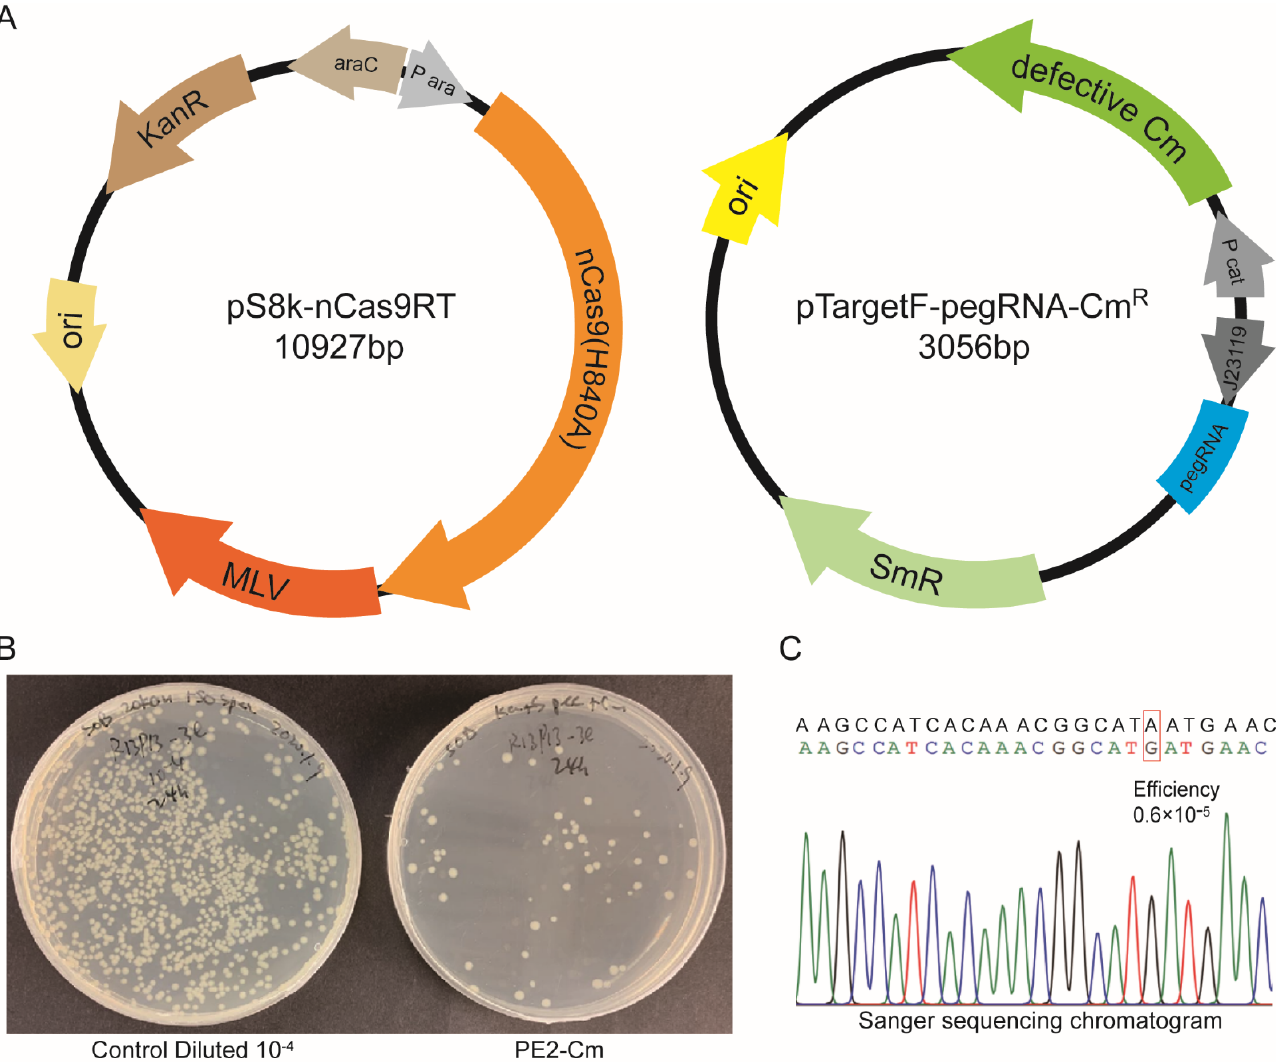
Figure 2. Prime editing in E. coli . ( A ) Diagram of the PE2 system plasmids in E. coli . The pS8k- nCas9RT consists of nCas9(H840A) fused to M-MLV RT induced by arabinose inducible promoter and Kan resistance. The pTargetF-pegRNA-Cm R consists of dysfunctional Cm R H139Y, pegRNA targeting Cm R H139Y expressed via constitutive J23119 promoter, and spectinomycin resistance gene. ( B ) Dual-plasmid transformed E. coli MG1655 was serially diluted and plated. Control diluted 10 − 4 on kan + spec plate (left), recovered Cm R via PE2 on kan + spec + cm plate. ( C ) A sanger se- quencing chromatogram and editing efficiency.